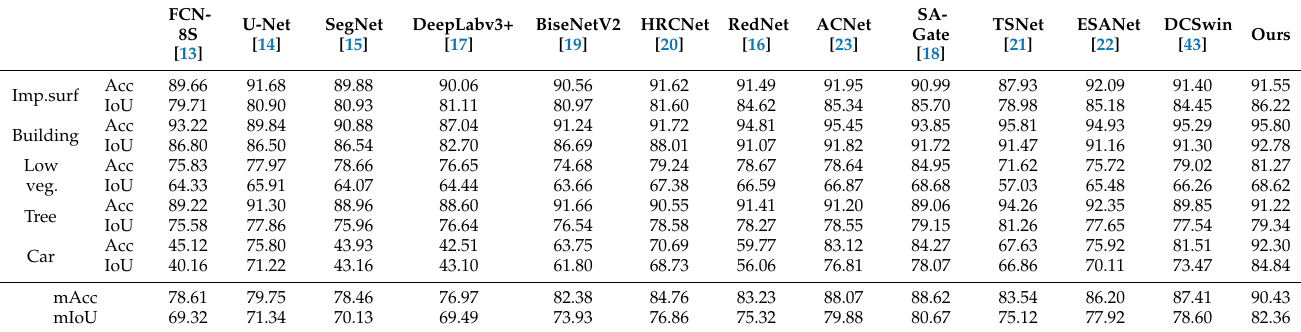
Table 1. Quantitative results of the proposed DGPRNet and 11 state-of-the-art methods on the Vaihingen dataset. The values in bold indicate the best scores in the evaluation matrix.